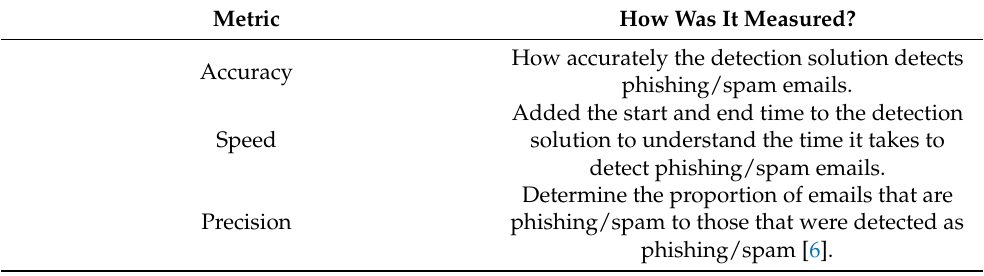
Table 4. Performance metrics.